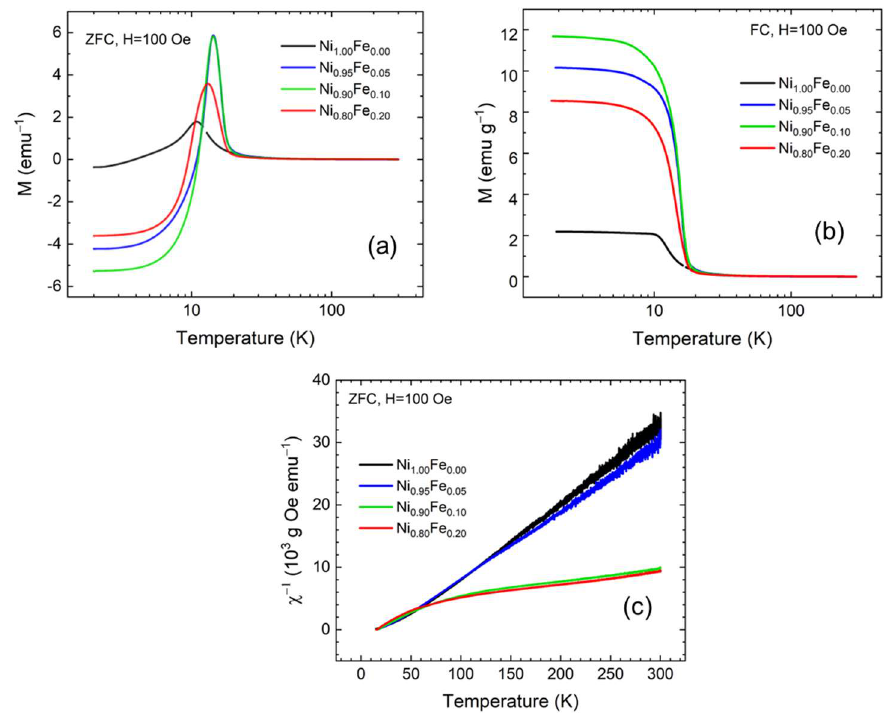
Figure 5. Magnetization curves for ( a ) ZFC and ( b ) FC conditions, and ( c ) Inverse susceptibility for Ni 1.00 Fe 0.00 , Ni 0.95 Fe 0.05 , Ni 0.90 Fe 0.10 , and Ni 0.80 Fe 0.20 (samples with up to 20 % Fe) measured in a 100 O e applied field.